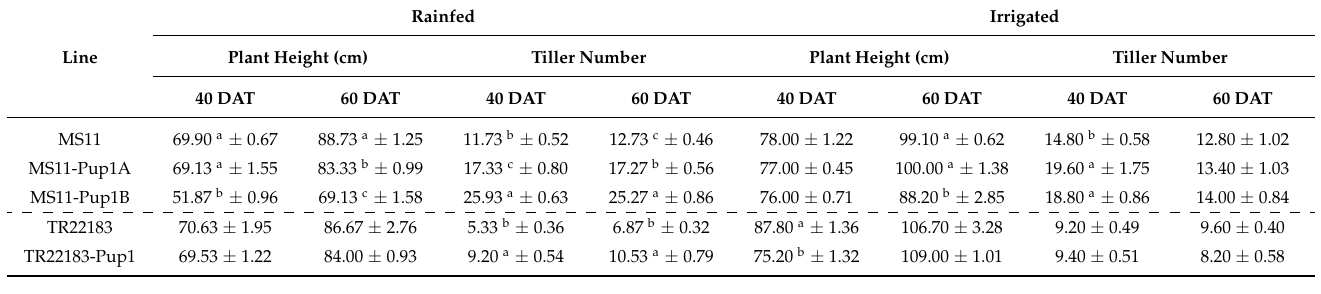
Table 3. Vegetative stage response of Temperate-Pup1 introgression lines under rainfed and irrigated conditions (2021). Means with the same letters within a genetic background, treatment, and timepoint are not significantly different using DMRT at p = 0.05. Values are means ± SE.